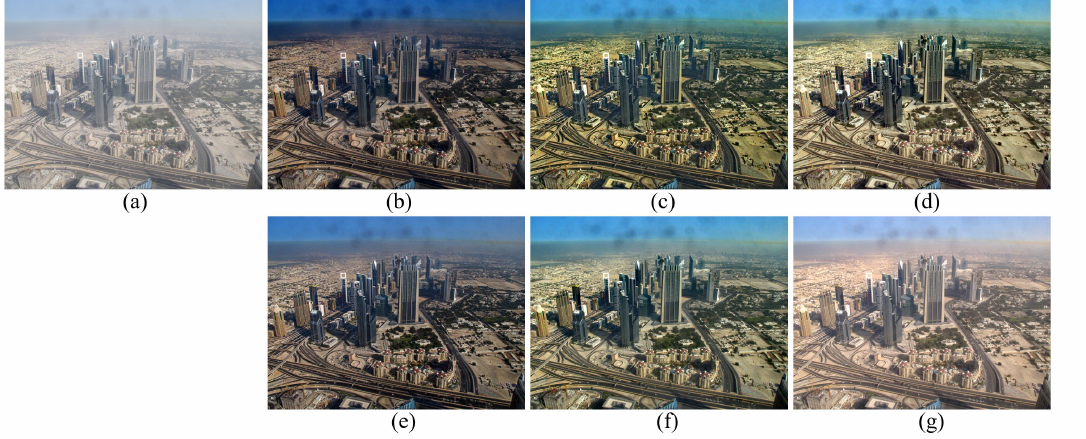
Figure 11. Experimental results of haze removal using the proposed and existing methods: ( a ) an input haze image [16], reproduced with permission from [16], IEEE, 1969, ( b ) He’s method [1], ( c ) Meng’s method [9], ( d ) Berman’s method [8], ( e ) Zhu’s method [2], ( f ) Ren’s method [6], and ( g ) the proposed